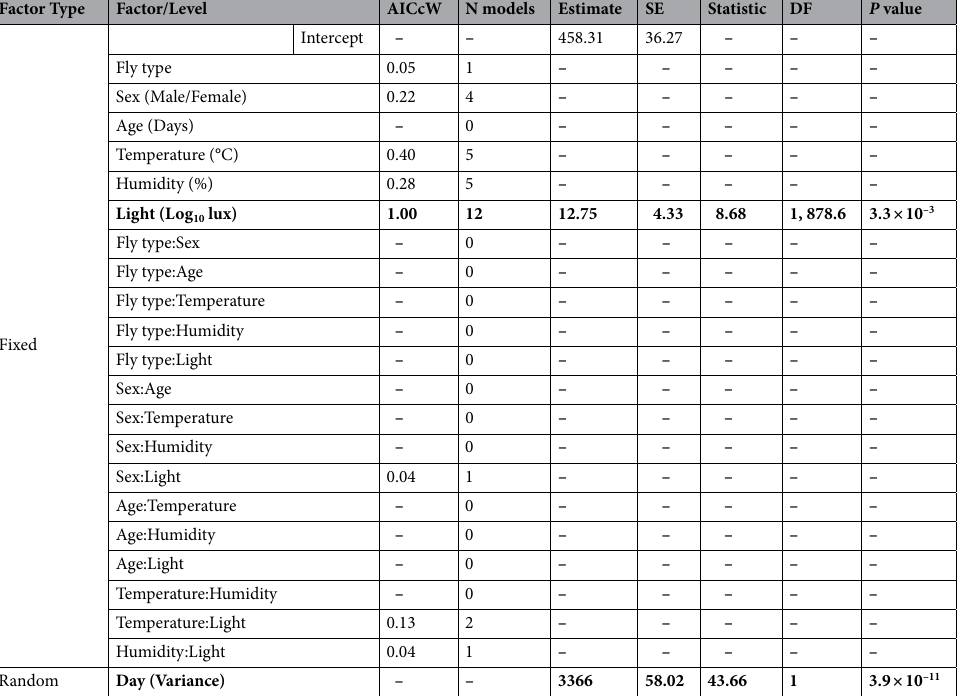
Table 2. Mixed-model ANOVA results for the best model (AICc min ; bolded) with radius (mm) as response variable. The sum of weights for the corrected Akaike Information Criterion (AICcW) and N models (total = 12) with AICcΔ < 4 for each factor are summarized here. The significance of fixed factors was assessed using F-statistic in a type III ANOVA with Satterthwaite’s method. The random factor was assessed using log- likelihood ratio with significance analyzed using a chi-square